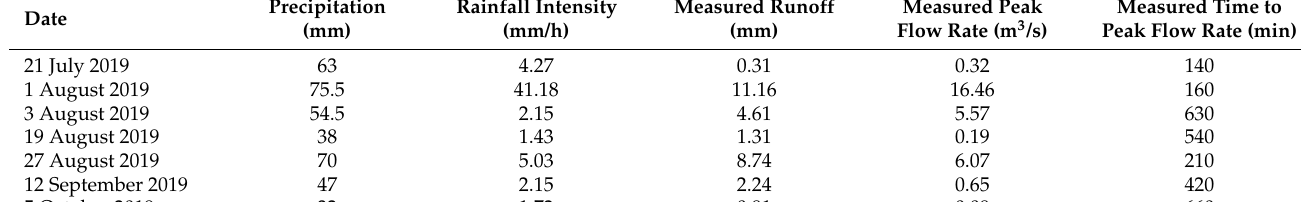
Table 2. Measured rainfall and runoff at watershed outlet in 2019.